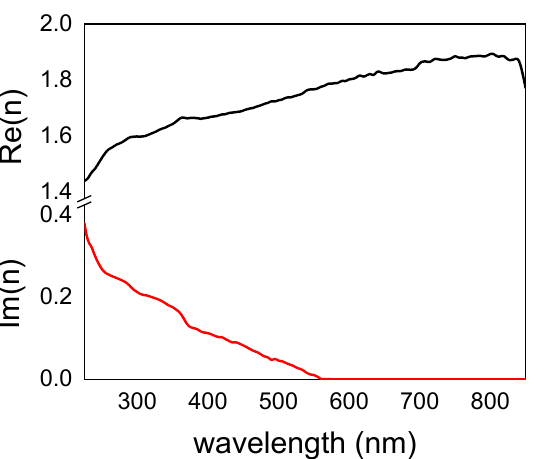
Figure 6. The real ( — ) and imaginary part ( — ) of the refractive index of the poly-L-DOPA as a function of the wavelength.